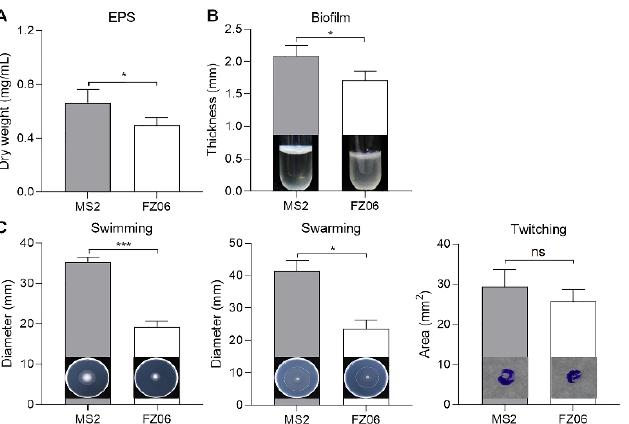
Figure 2. Measurement of EPS ( A ), biofilm formation ( B ), and cell motility ( C ) of strains FZ06 and MS2. GraphPad Prism 8.4.1 was used to perform unpaired two-tailed t -tests, and the data of strain FZ06 were compared with those of strain MS2. The data represent the means of three replicates, and error bars represent the standard deviation. “ns” indicates not significant, * indicates p < 0.05, and *** indicates p < 0.001.